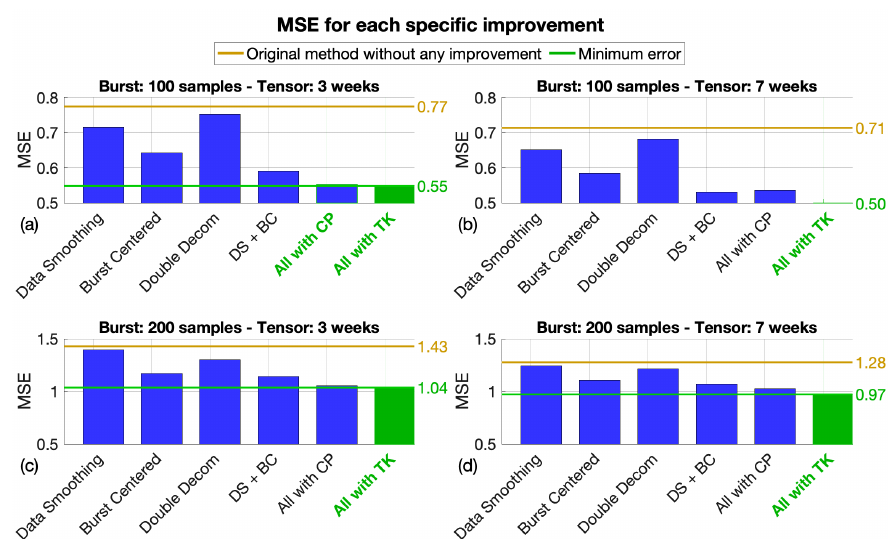
Figure 11. MSE of the proposed improvements. All of them are tested with 100 and 200 samples of data burst lost and with 3 and 7 weeks of tensorized data. The orange line indicates the best result obtained in [14]. The Smooth is the result of applying only the smooth process to the signal before tensorizing it. The burst centered tensorization is the result of the rearrangement of the tensor according to the burst location. The Double decom is the result of applying the decomposition two times, with G 4 × 6 × 1 and G 4 × 7 × 7 for Tucker, and G 1 × 1 × 1 and G 15 × 15 × 15 for CP. The DS-Bc is the result of combining the data smoothing and the burst centered tensorization without using the double decomposition. The All with CP and the All with TK are the results of applying all the proposed algorithm with the CP and the Tucker models